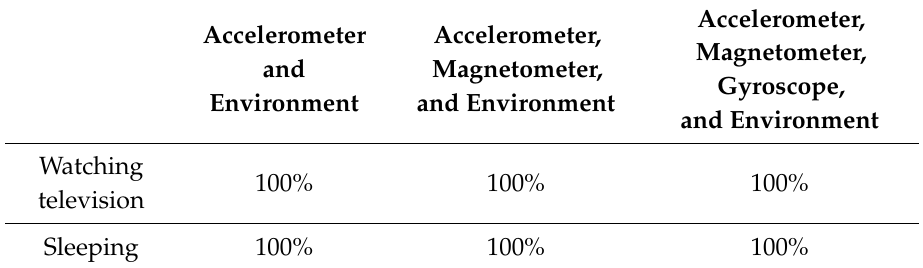
Table 14. Accuracies of the activities’ recognition without motion using the AdaBoost with the decision stump method implemented with Weka software for motion, magnetic, and location sensors after the